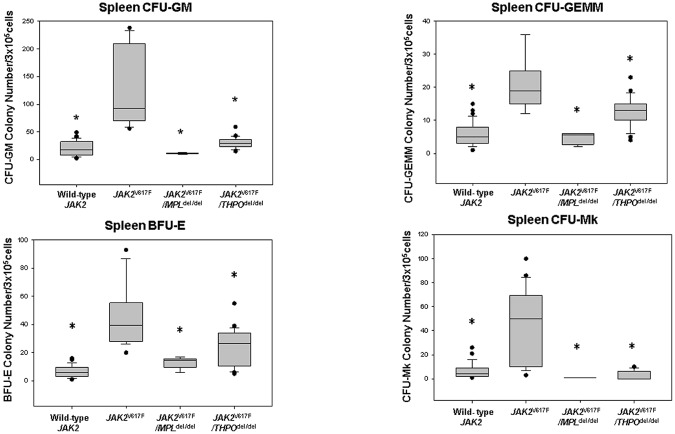
MPLdel, and THPOdel genotypes mitigate spleen HPC colony formation in a JAK2V617F transgenic mouse model of PV.(A) In vitro colony formation by spleen CFU-GM from JAK2V617F transgenic mice was increased compared to wild-type mice and JAK2V617F/MPLdel/del and JAK2V617F/THPOdel/del transgenic mice (*P < 0.001). (B) In vitro colony formation by spleen CFU-GEMM from JAK2V617F transgenic mice was increased compared to wild-type mice and JAK2V617F/MPLdel/del and JAK2V617F/THPOdel/del transgenic mice (*P < 0.001). (C) In vitro colony formation by spleen BFU-E from JAK2V617F transgenic mice was increased compared wild-type mice and JAK2V617F/MPLdel/del and JAK2V617F/THPOdel/del transgenic mice. (*P < 0.001) (D) In vitro colony formation by spleen CFU-Mk from JAK2V617F transgenic mice was increased compared to wild-type mice and JAK2V617F/MPLdel/del and JAK2V617F/THPOdel/del transgenic mice (*P < 0.001). The horizontal lines of the boxes indicate the 25th percentile, the median and 75th percentile respectively and the error bars indicate the 10th and 90th percentiles.*P <0.001. The number of mice of each genotype used in all the experiments is the same as in Fig 2.